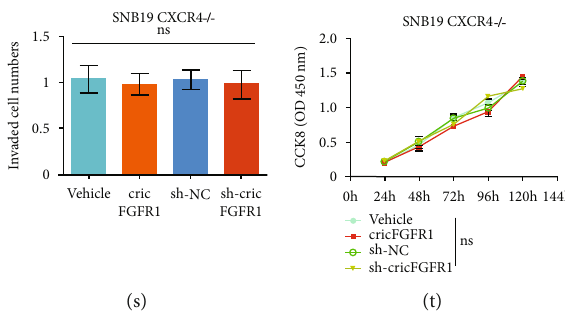
Figure 2: The circFGFR1-induced exasperated glioma progression is attributed to CXCR4 upregulation. (a) The clinical data of CXCR4 expression in the normal persons and GBM patients from the GEPIA Database. (b) The expression pro fi le of CXCR4 mRNA in di ff erent cell lines and NHA analyzed by qPCR. (c) The correlation of CXCR4 mRNA level and circFGFR1 level in di ff erent cell lines and NHA. (d, e) The expression of CXCR4 protein in di ff erent cell lines and NHA analyzed by western blot. (f – l) SNB19 cells overexpressing Vehicle, circFGFR1, sh-NC, and sh-circFGFR1, respectively, by transducing lentivirus and screening with puromycin. (f) The expression of CXCR4 mRNA in engineered SNB19 stable cell lines analyzed by qPCR. (g, h) The expression of CXCR4 protein in engineered SNB19 stable cell lines analyzed by western blot. (i) The expression of CXCR4 mRNA in xenograft tumors analyzed by qPCR. (j, k) The expression of CXCR4 protein in xenograft tumors analyzed by western blot. (l) The expression of CXCR4 mRNA and circFGFR1 in WT SNB19 cells and SNB19 CXCR4-/- cells analyzed by qPCR. (m, n) The expression of CXCR4 protein in WT SNB19 cells and SNB19 CXCR4-/- cells analyzed by western blot. (o – t) SNB19 CXCR4-/- cells overexpressing Vehicle, circFGFR1, sh-NC, and sh-circFGFR1, respectively, by transducing lentivirus and screening with puromycin. (o) The expression of circFGFR1 in engineered SNB19 CXCR4-/- stable cell lines analyzed by qPCR. (p, q) The migration ability of those engineered SNB19 CXCR4-/- stable cell lines analyzed by Matrigel-free Transwell assay. (r, s) The invasion ability of those engineered SNB19 CXCR4-/- stable cell lines analyzed by Matrigel-based Transwell assay. (t) The proliferation ability of engineered SNB19CXCR4-/- cell lines analyzed by CCK8 assay. The data are presented as the means ± SD , n = 3 experiments in (b – h) and (l – t), n = 6 experiments in (i – k), ∗ p < 0 : 05 , ∗∗ p < 0 : 01 , ∗∗∗ p < 0 : 005